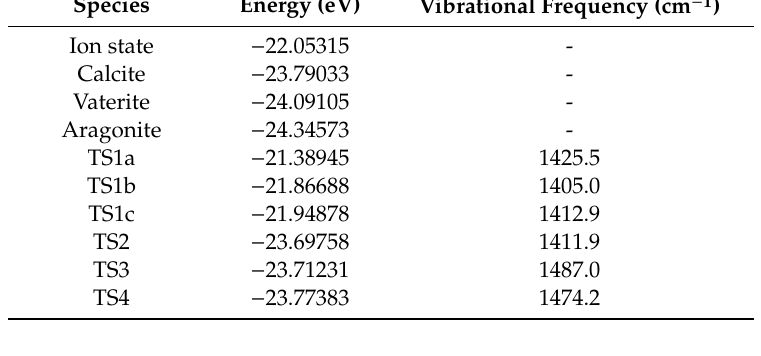
Table 5. Energy and frequency of reaction of Ca 2 + and [CO 3 ] 2 − .